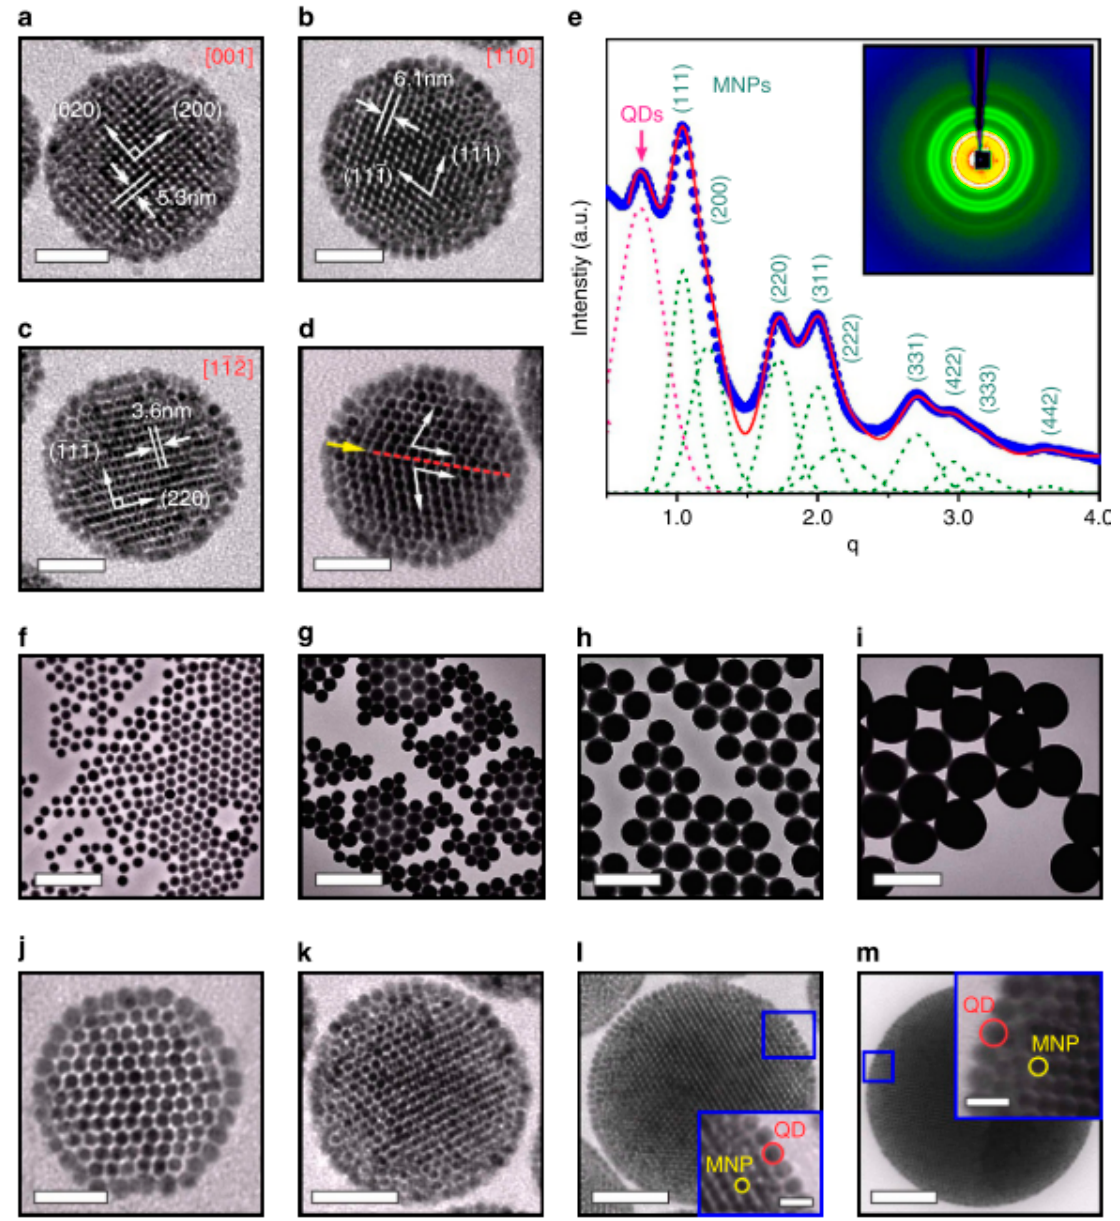
Figure 21. Supercrystalline CS-SPs (core–shell supernanoparticles) and their size-controlled syntheses. TEM images of supercrystalline CS-SPs viewed along di ff erent zone axes ( a ) (0 0 1), ( b ) (1 1 0) and ( c ) (1 -1 -2) ( d ) TEM image of a CS-SP with a stacking fault marked with a yellow arrow. Scale bars, 50 nm ( a – d ). ( e ) The integrated data from the SAXS pattern (inset) of CS-SPs show a position ratio √ √ √ √ √ √ √ √ series of q / q0 = 1 / (4 / 3) / (8 / 3) / (11 / 3) / (4) / (19 / 3) / (8) / (9) / (12) (q0 is the position of the (111) peak) indicating an fcc close packing of the MNPs. Large-area TEM images ( f–i ) and higher magnification TEM images (j–m) of CS-SPs with an average diameter of 80 ± 9 nm ( f , j ), 120 ± 13 nm ( g , k ), 235 ± 30 nm ( h , l ), and 360 ± 60 nm ( i , m ). The insets in l and m are zoomed-in images of the blue squares. Scale bars, 500 nm ( f – i ). Scale bars, 30 nm, 50 nm, 70 nm and 100 nm ( j – m ), respectively. Scale bars, 15 nm (insets of l and m). Red and yellow circles indicate the positions of QDs and MNPs, respectively. (Reprinted by permission from Copyright Clearance Center: Spinger Nature, Nature Communications, [144], Copyright